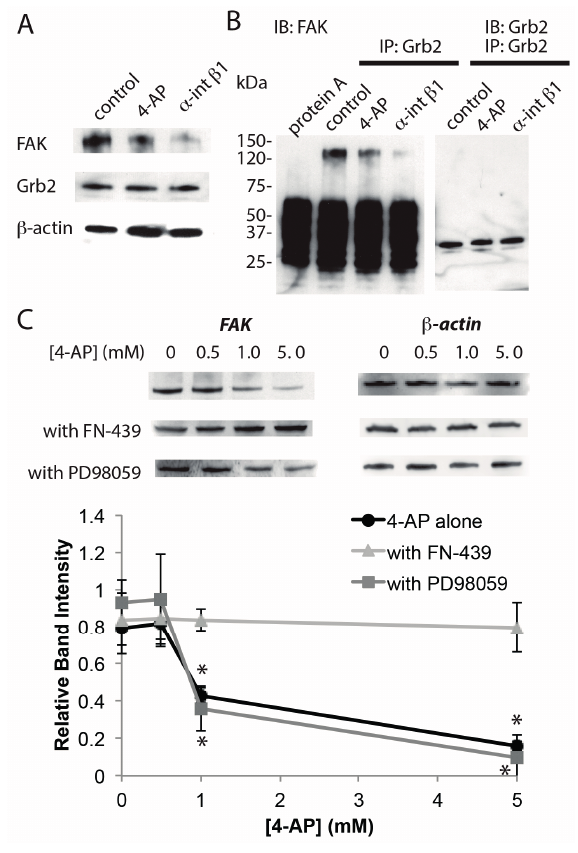
Figure 3. Interaction between FAK-Grb2 is impaired by chronic network activation. ( A ) Western blot analysis of FAK and Grb2; ( B ) Immuno-precipitation analysis of Grb2. Samples were immuno-precipitated with anti-Grb2 antibody, and then immuno-blotted with anti-FAK or anti-Grb2 antibodies. Neurons were incubated with 5 mM 4-AP or 50 μ g/mL anti-integrin β 1 antibody for 18 h; and ( C ) Inhibition of MMPs blocks the effect of chronic activation on FAK levels. Neurons were incubated with the indicated concentrations of 4-AP (with 50 μ M FN-439 or 50 μ M PD98059) for 18 h ( n = 4, * p < 0.05, one-way